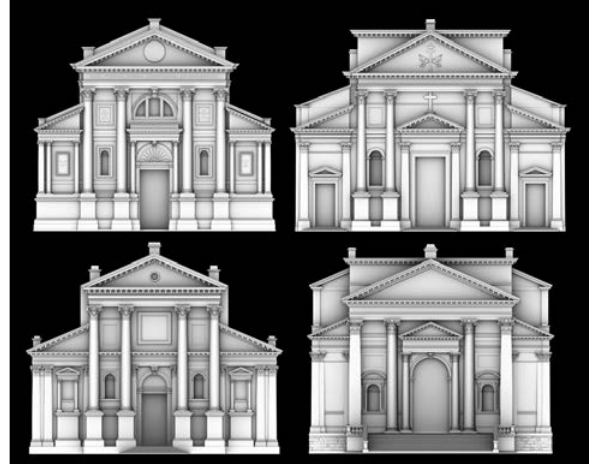
Figure 5. 3D models of the Palladian churches in Venice: Ambient Occlusion (AO) visualization.